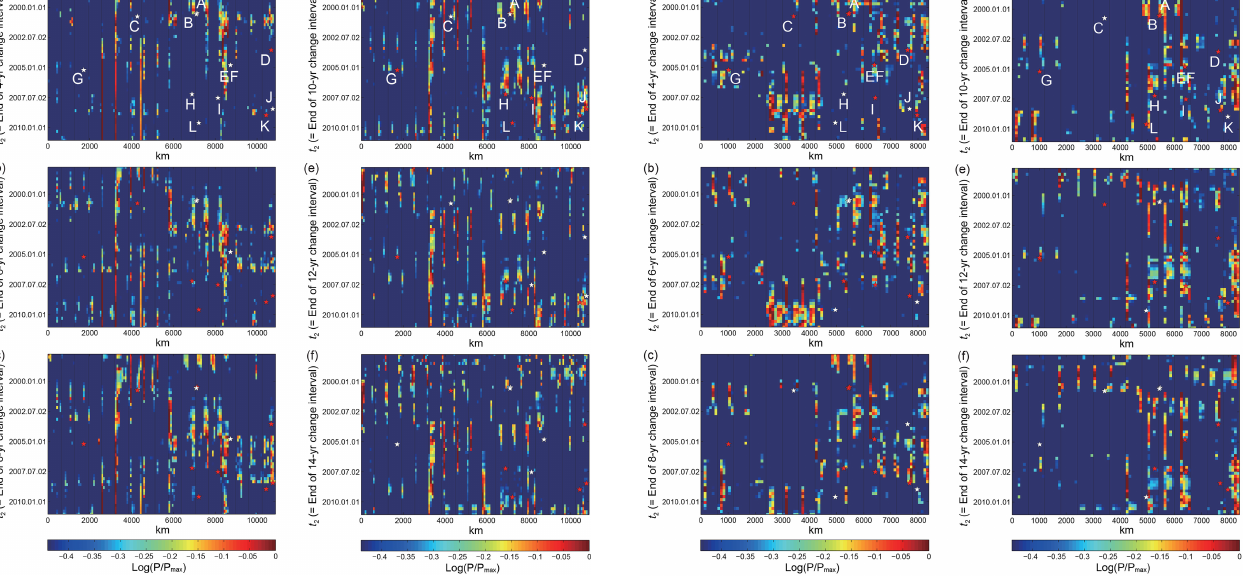
Fig. 3. Spatiotemporal PI maps for a cutoff magnitude of 3.5, illus- trating the locations of grid cells with large seismicity changes (PI hotspots) for different change intervals between t 1 and t 2 ( t 2 − t 1 = 4, 6, 8, 10, 12, and 14 years; t 2 = 1 January 1997–28 February 2011). Length of change interval for each panel is shown on the labels of vertical axes. Log( P/P max ) means the common logarithm of the PI value (Fig. 2a). Grid cells with the common logarithm of PI values greater than − 0.4 (i.e., between − 0.4 and 0) are regarded as locations with large seismicity changes, including seismic qui- escence and activation, during the specified change interval. Red grid cells correspond to the highest probability of earthquake occur- rence. Deep blue cells indicate values lower than − 0.4, representing locations with small seismicity changes and indicating low proba- bilities of earthquake occurrences in the prediction periods follow- ing the change intervals. Horizontal and vertical axes denote the cumulative distance along the Y axis and the end of change inter- val used for evaluating seismicity change, respectively (Figs. 1, 2b). The red stars indicate the locations of target earthquakes that oc- curred in the prediction periods following the change intervals with large seismicity changes. The white stars denote those with small seismicity changes. The vertical black lines, which correspond to those in the spatiotemporal PI map as shown in Fig. 2, represent the north-northwest and south-southeast edges of the Y axis of the rectangular analysis region as shown in Fig. 1. The labels (A)–(L) correspond to the earthquake indices in Table 1.